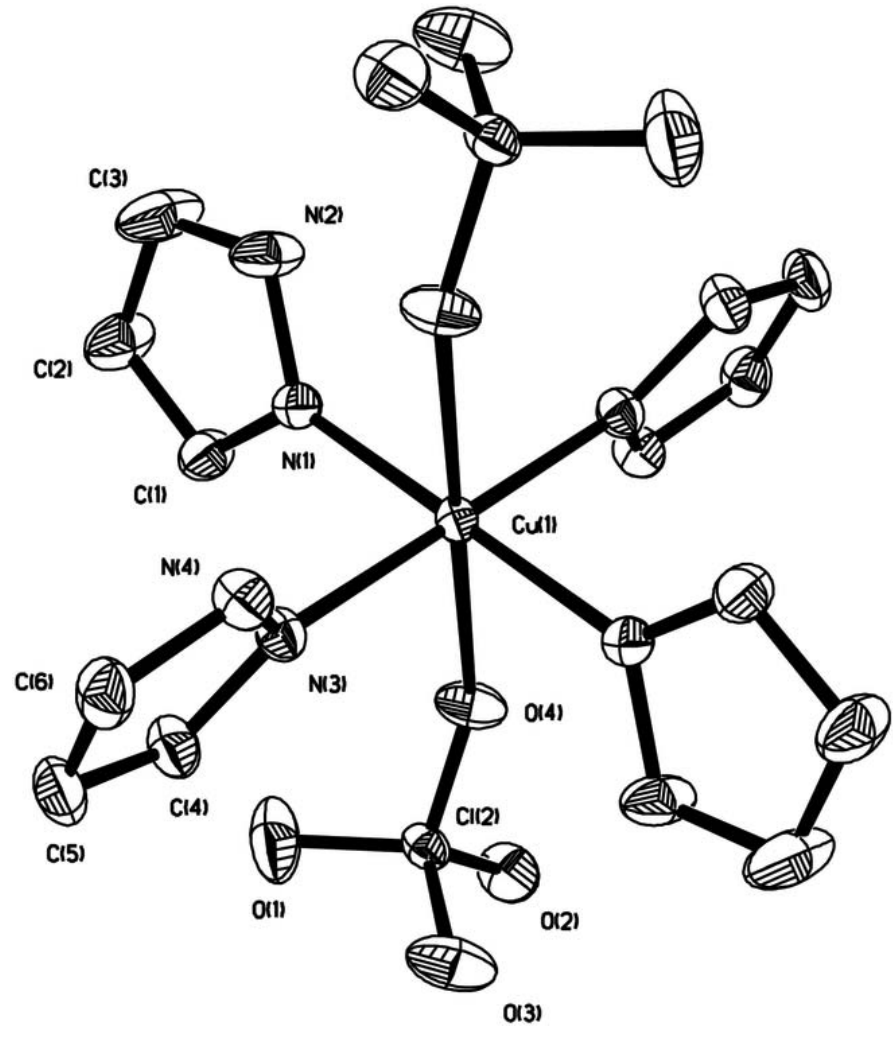
The molecule of the title compound in the crystal. Thermal ellipsoids represent 50% probability levels. H-Atom radii are